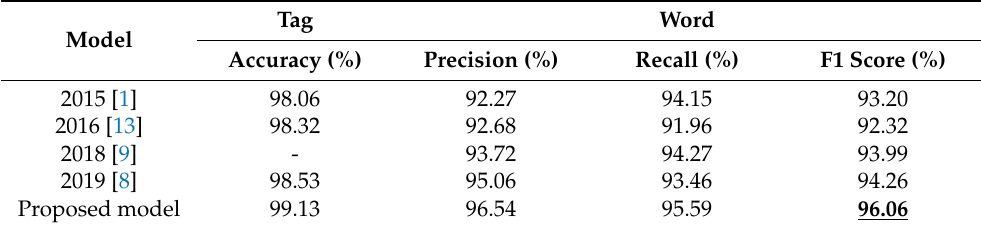
Table 6. Comparison with previous spacing studies. Marked in bold and underline is the best performance.